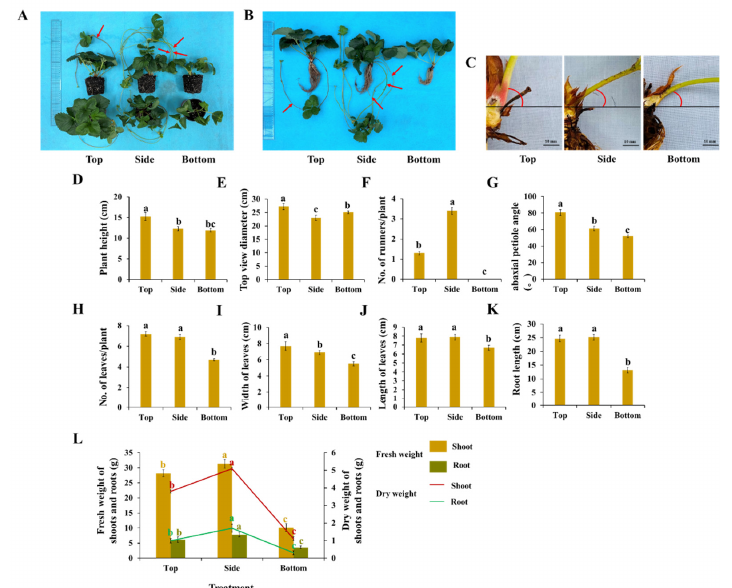
Figure 1. Changes in the phenotype and plant traits of strawberry ‘Sulhyang’ plants as affected by the lighting direction after 45 days of cultivation. The plant morphology ( A ), root state and length ( B,K ), abaxial petiole angle of the outermost leaves ( C,G ), plant height ( D ), top view diameter of plants ( E ), number of runners per plant ( F ), number of leaves per plant ( H ), length and width of the largest fully-expanded leaves ( I,J ), fresh and dry weights of plant shoots and roots ( L ). Vertical bars indicate the means ± standard error ( n = 6). Different lowercase letters indicate significant separa- tions within treatments by Duncan’s multiple range test at p ≤ 0.05. Bars indicate 10 mm. Red arrows indicate runners per plant.